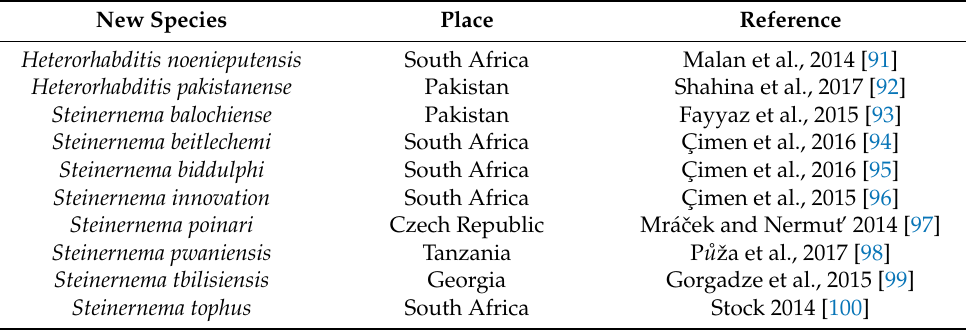
Table 2. Recently discovered species of entomopathogenic